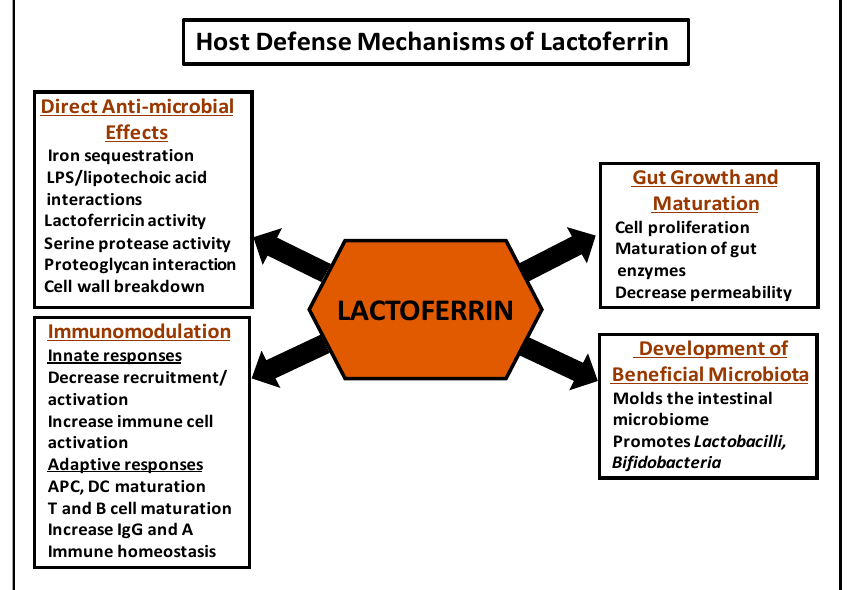
Figure 1. Functions of Lactoferrin in Neonatal Host Defense.